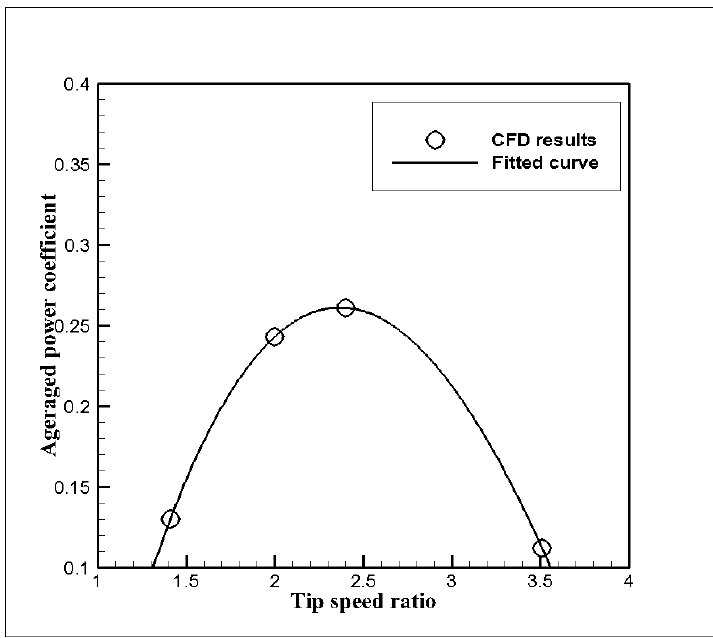
Figure 13. Averaged power coefficient of the spherical turbine with respect to TSR.